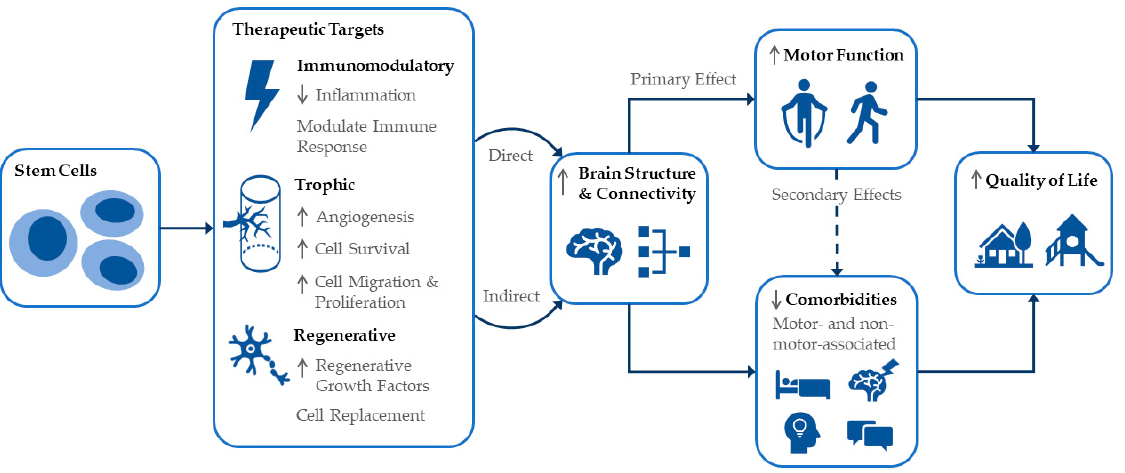
Figure 3. Schematic representation of cell intervention effects and interlinked outcomes for CP including quality of life.